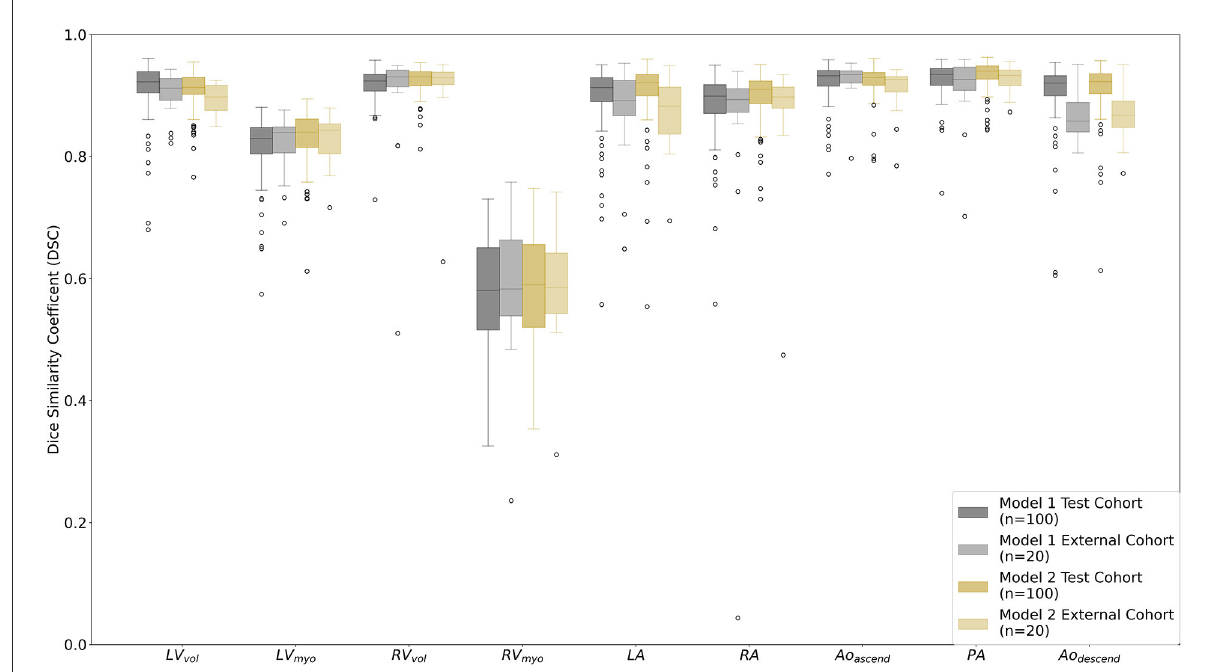
FIGURE3 Box plots comparing Dice similarity coefficient (DSC) for the segmented cardiac structures for DL model 1 vs. the manual segmentation observer 1 (AJS) and DL model 2 vs. observer 1 in the test cohort ( n = 100) and the external cohort ( n = 20). Structures are as follows; LV endocardial cavity (LV vol ), LV myocardium (LV myo ), RV endocardial cavity (RV vol ), RV myocardium (RV myo ), left atrium (LA), right atrium (RA), ascending aorta and aortic arc (Ao ascend ), proximal pulmonary arteries (PA), and descending aorta (Ao descend